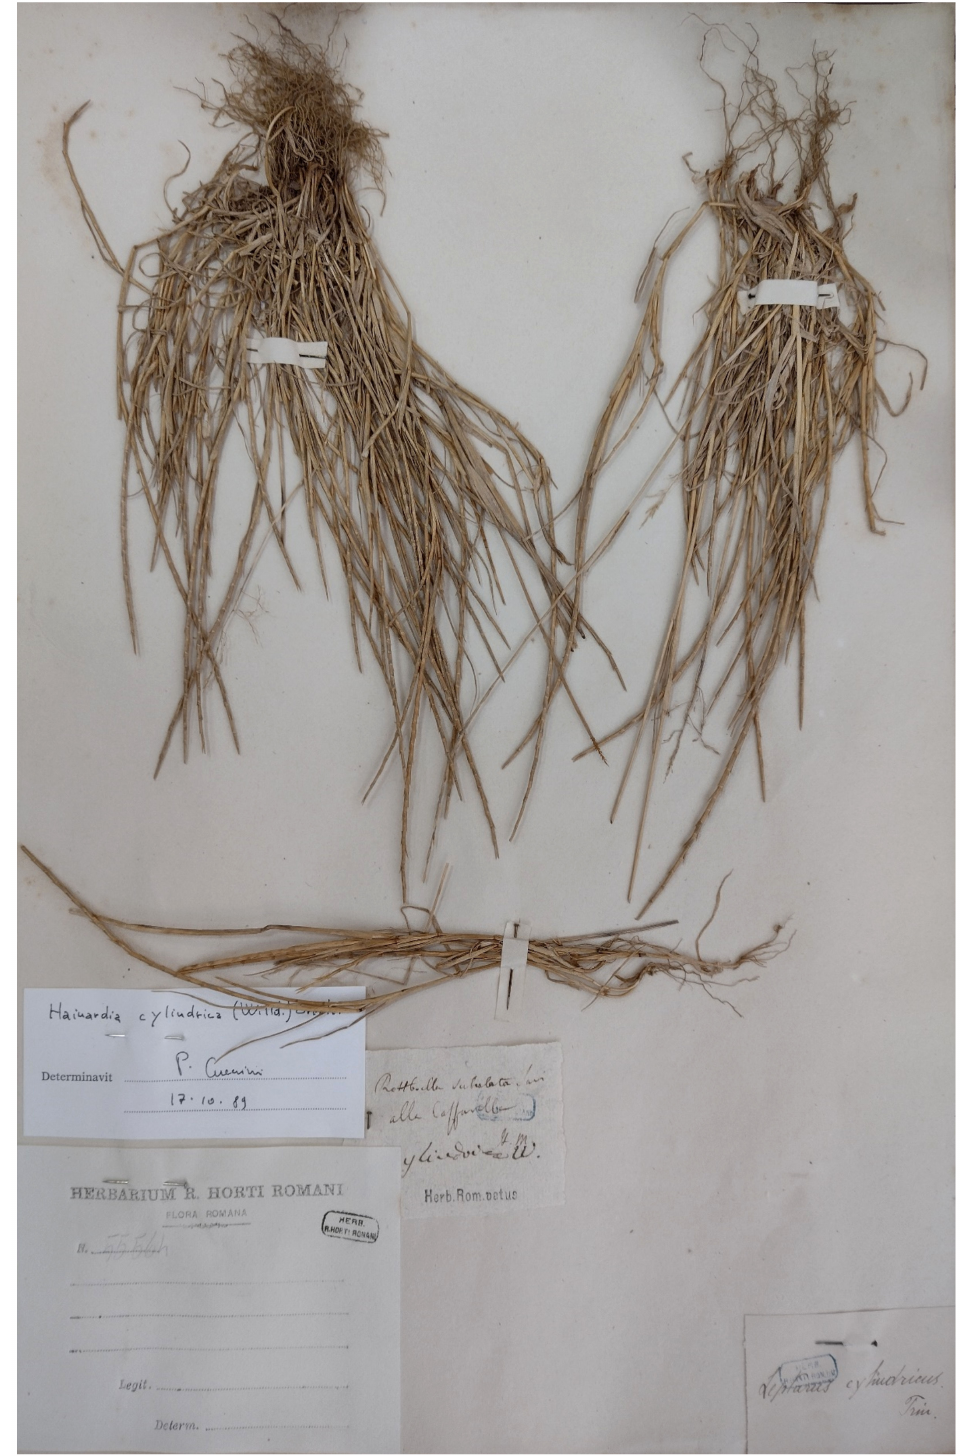
Figure 66. Specimen of Parapholis cylindrica collected in Caffarella valley in the 19th century (RO- Herbarium Romano no.